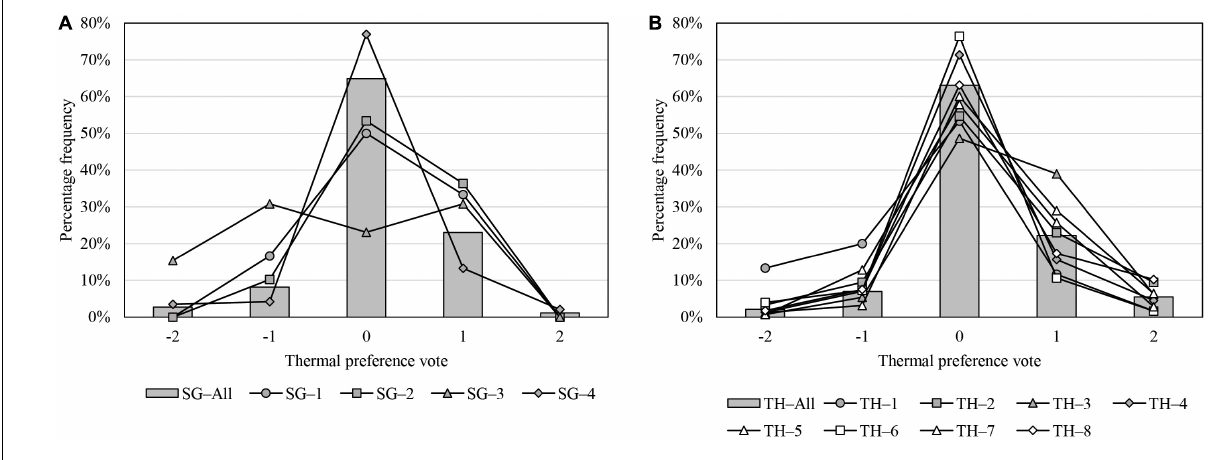
FIGURE 5 | Thermal preference votes: (A) Singapore and (B) Thailand. TABLE 6 | Average comfort operative temperature of Griffith’s method and subjective